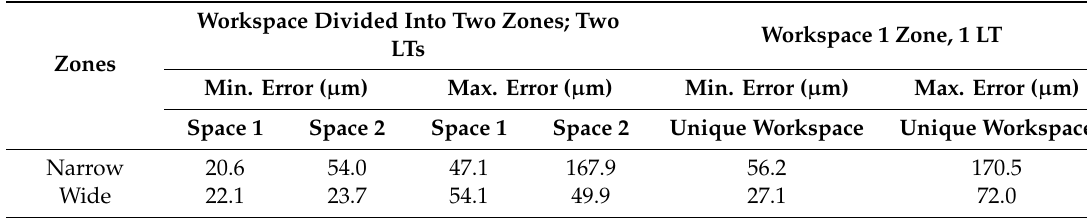
Table 1. Influence of LT uncertainty depending on location and number of devices.